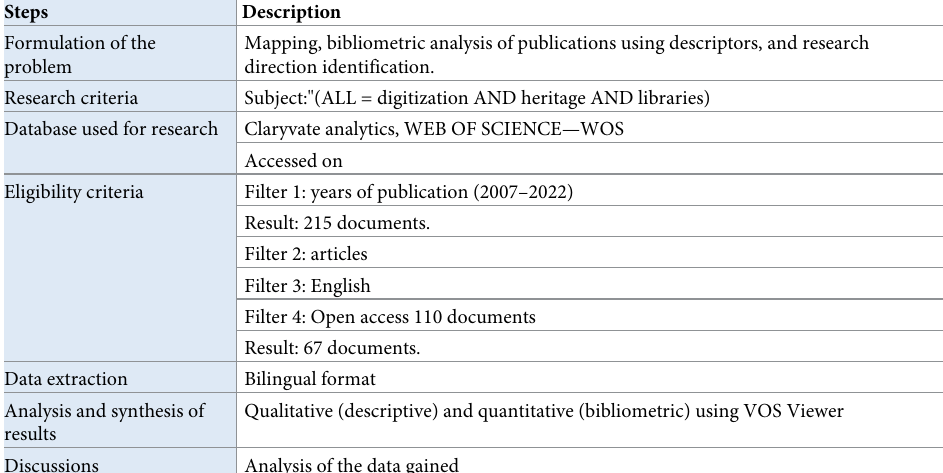
Table 1. Scientometric study